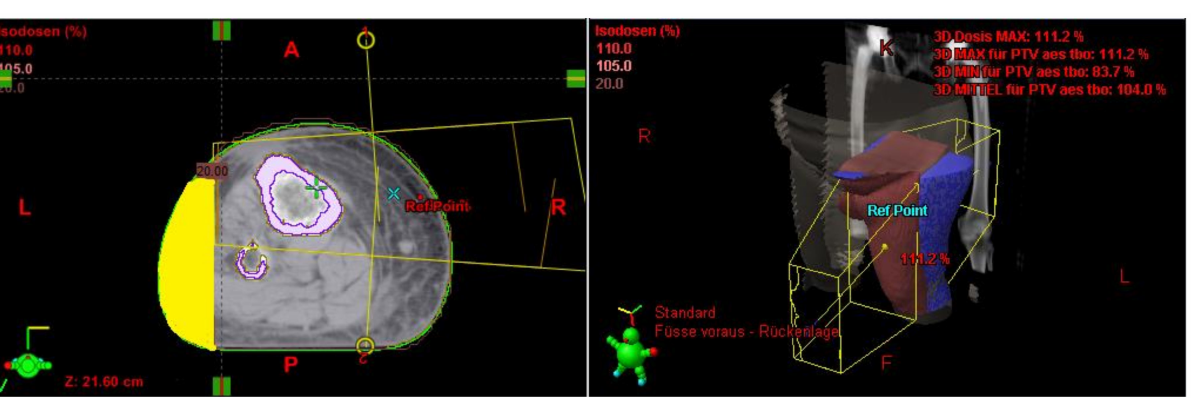
Figure 1. Relatively wide part of the lymph-sparing volume (yellow) outside the 20% isodose line.